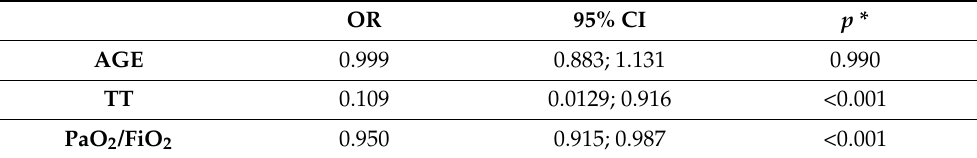
Table 2. Multivariable logistic regression analysis for CPAP Therapy using TT.